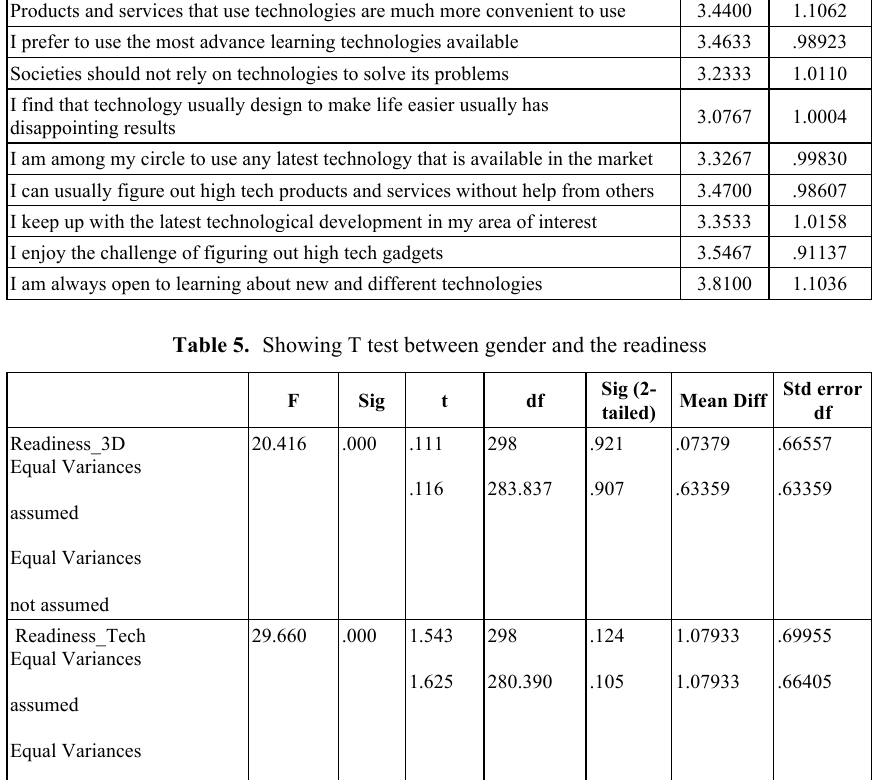
STD. Mean Deviation